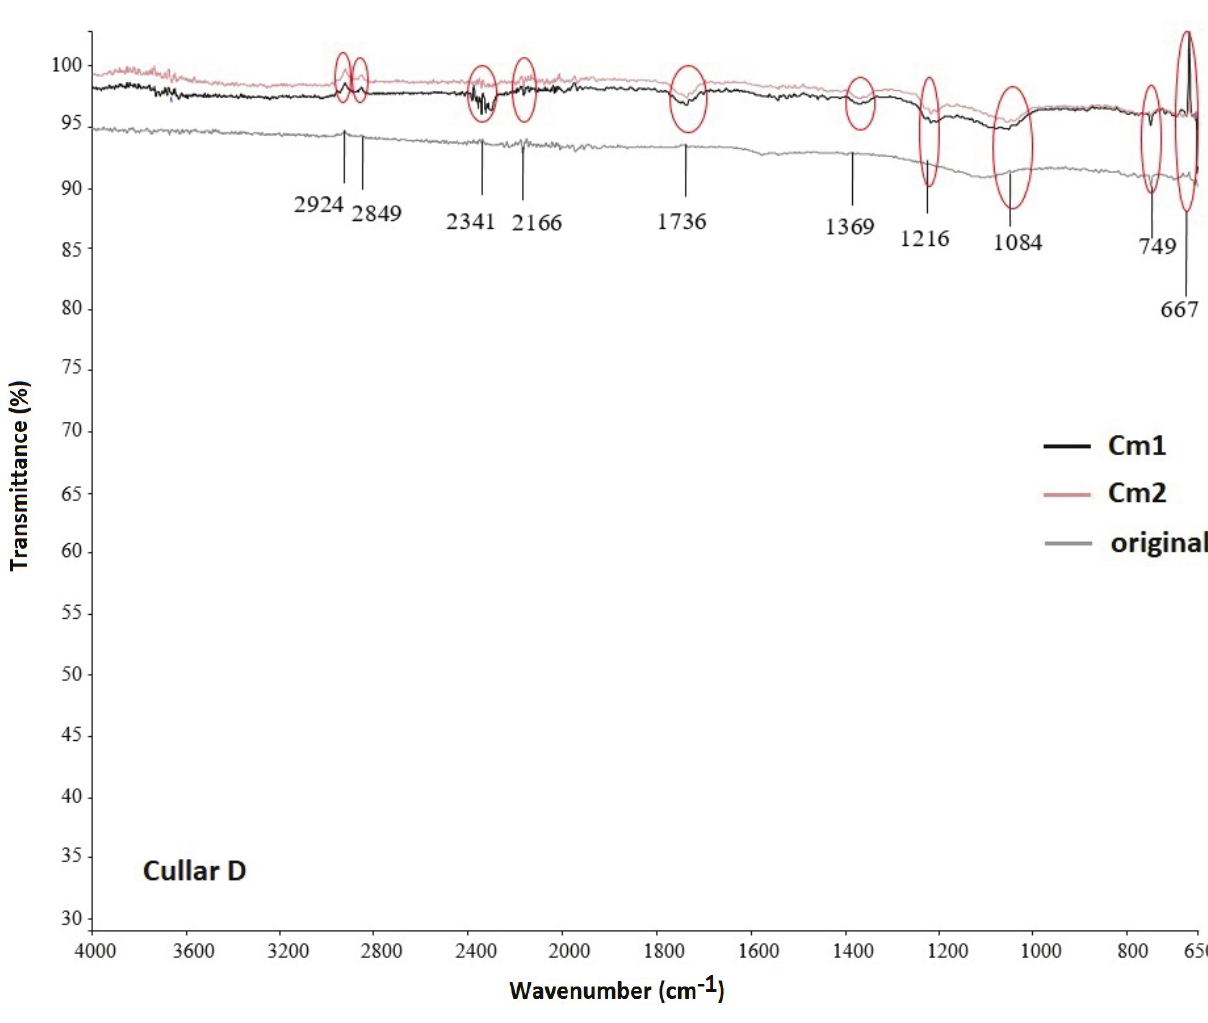
Fig. 1 – FTIR spectrum of activated carbon Cullar D in original, Cm1 and Cm2